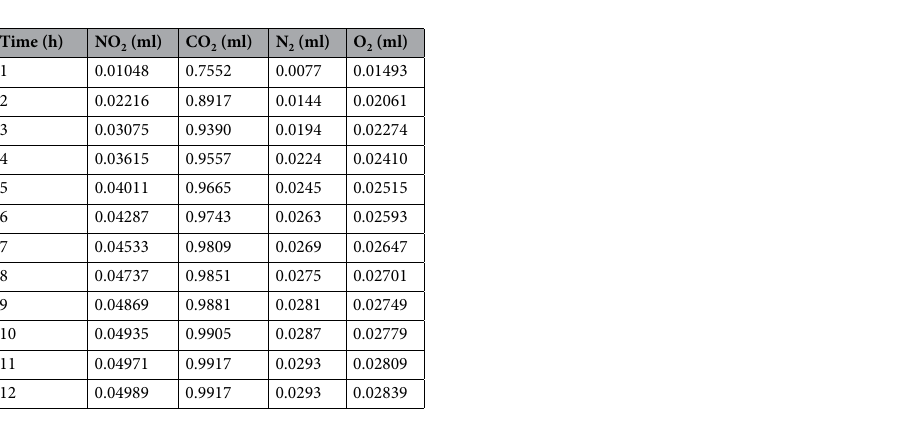
Table 6. Change of accumulated adsorption capacity of 1 g anthracite with